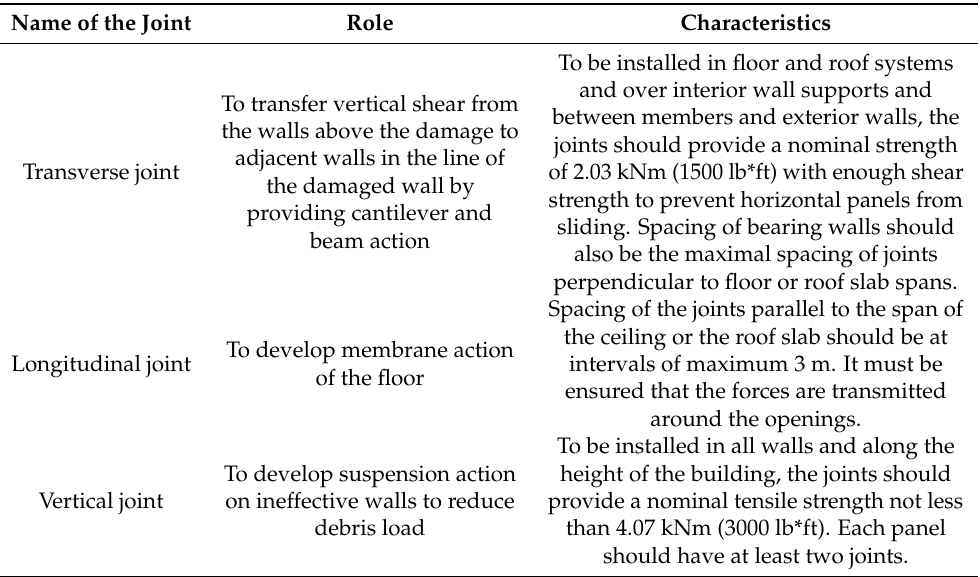
Table 3. Horizontal and vertical joints–recommendations based on results (based on the information provided in